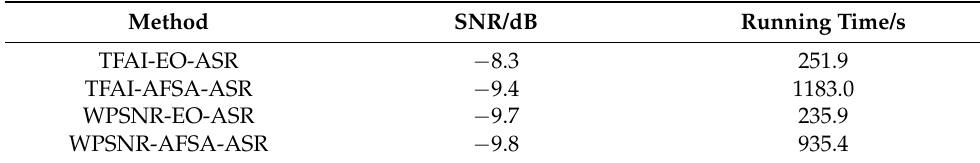
Figure 11. Results of ASR extraction: ( a ) waveform of TFAI-AFSA-ASR output; ( b ) spectrum of TFAI-AFSA-ASR output; ( c ) waveform of WPSNR-EO-ASR output; ( d ) spectrum of WPSNR-EO-ASR output; ( e ) waveform of WPSNR-AFSA-ASR output; ( f ) spectrum of WPSNR-AFSA-ASR output. Table 1. Parameters of adaptive stochastic resonance